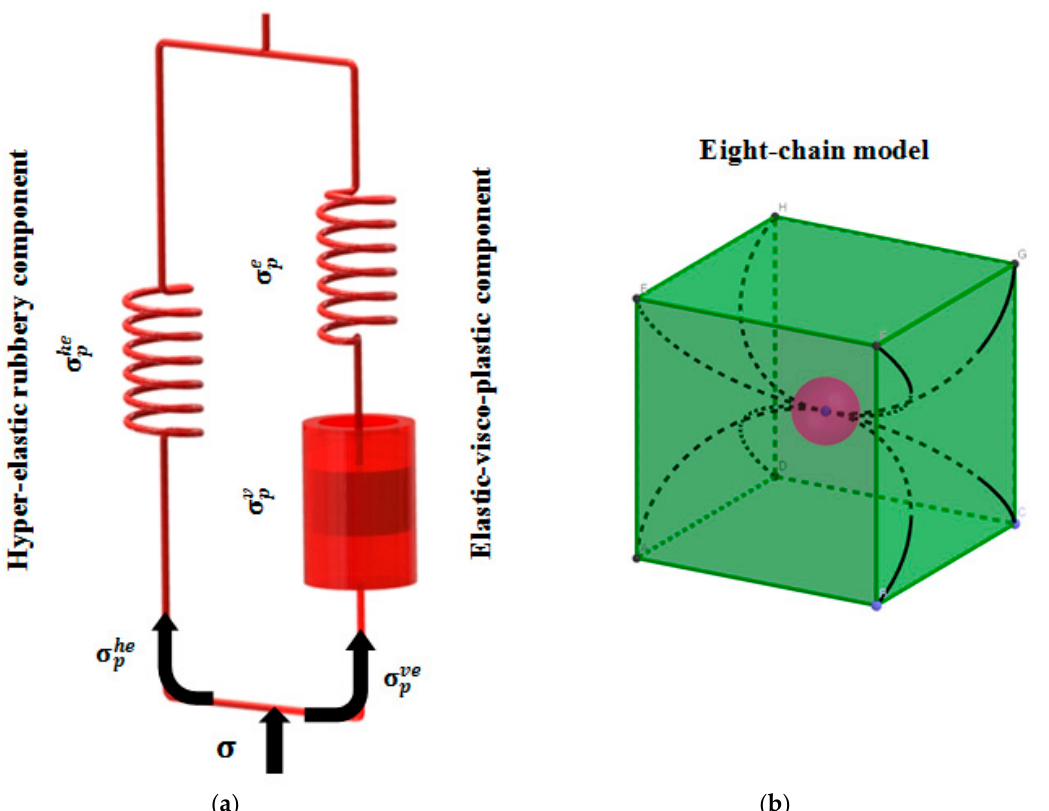
Figure 1. ( a ) Rheological Arruda–Boyce model for the stress response, and ( b ) the RVE (Representative Volume Element) of the structure.